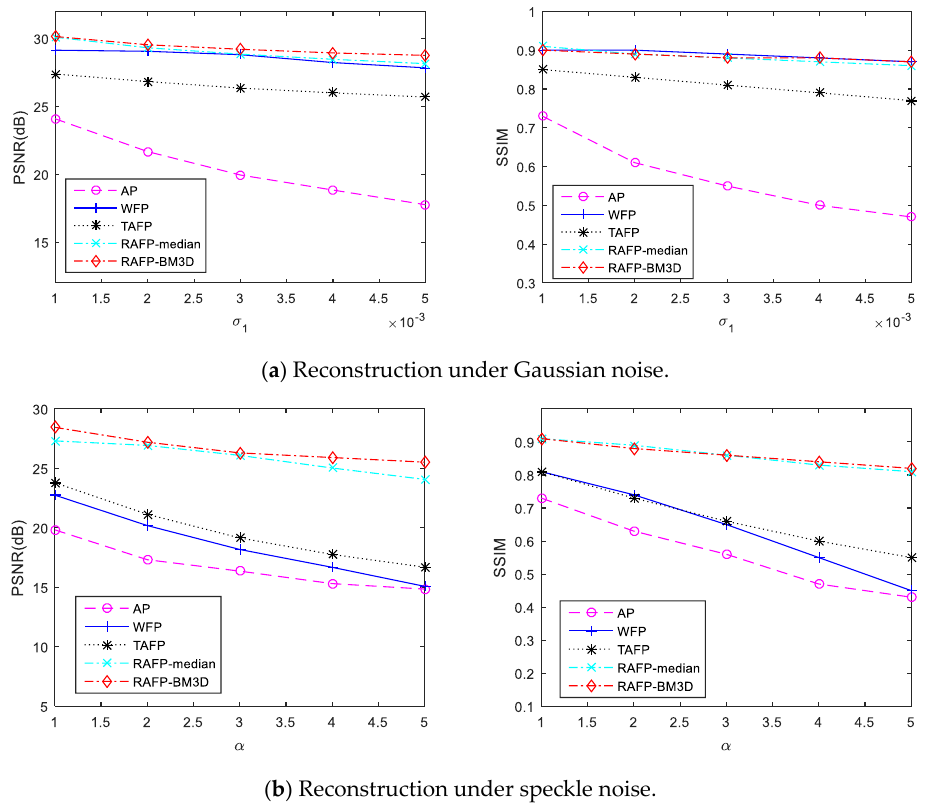
Figure 5. Quantitative comparison of the reconstruction results by different methods under Gaussian noise and speckle noise. Table 3. Comparison of running time between different algorithms.